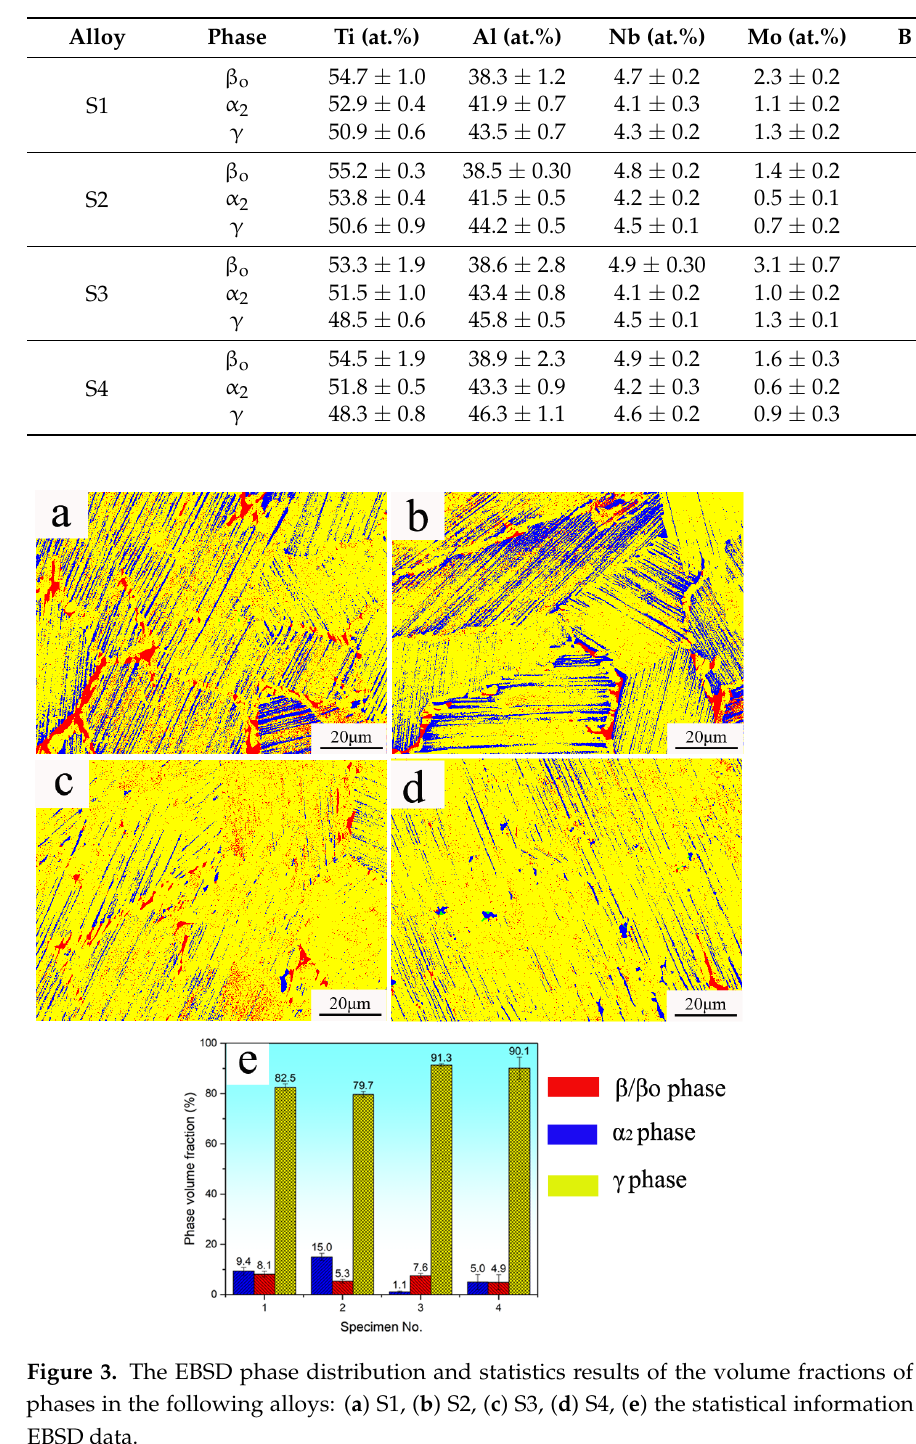
Table 2. The compositions of β o , α 2 and γ phase in the alloys by EDS.